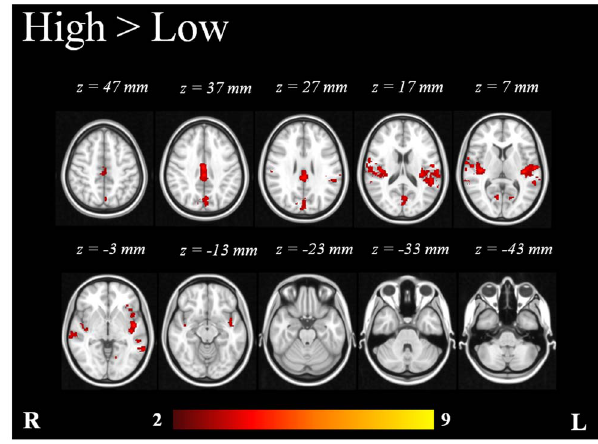
Figure 6. Mixed-effects statistical map of EEG-informed group analysis (n=16) showing additional clusters in high vs. low intensity tones. Statistically significant voxels were thresholded at p , 0.05. Color bar represents